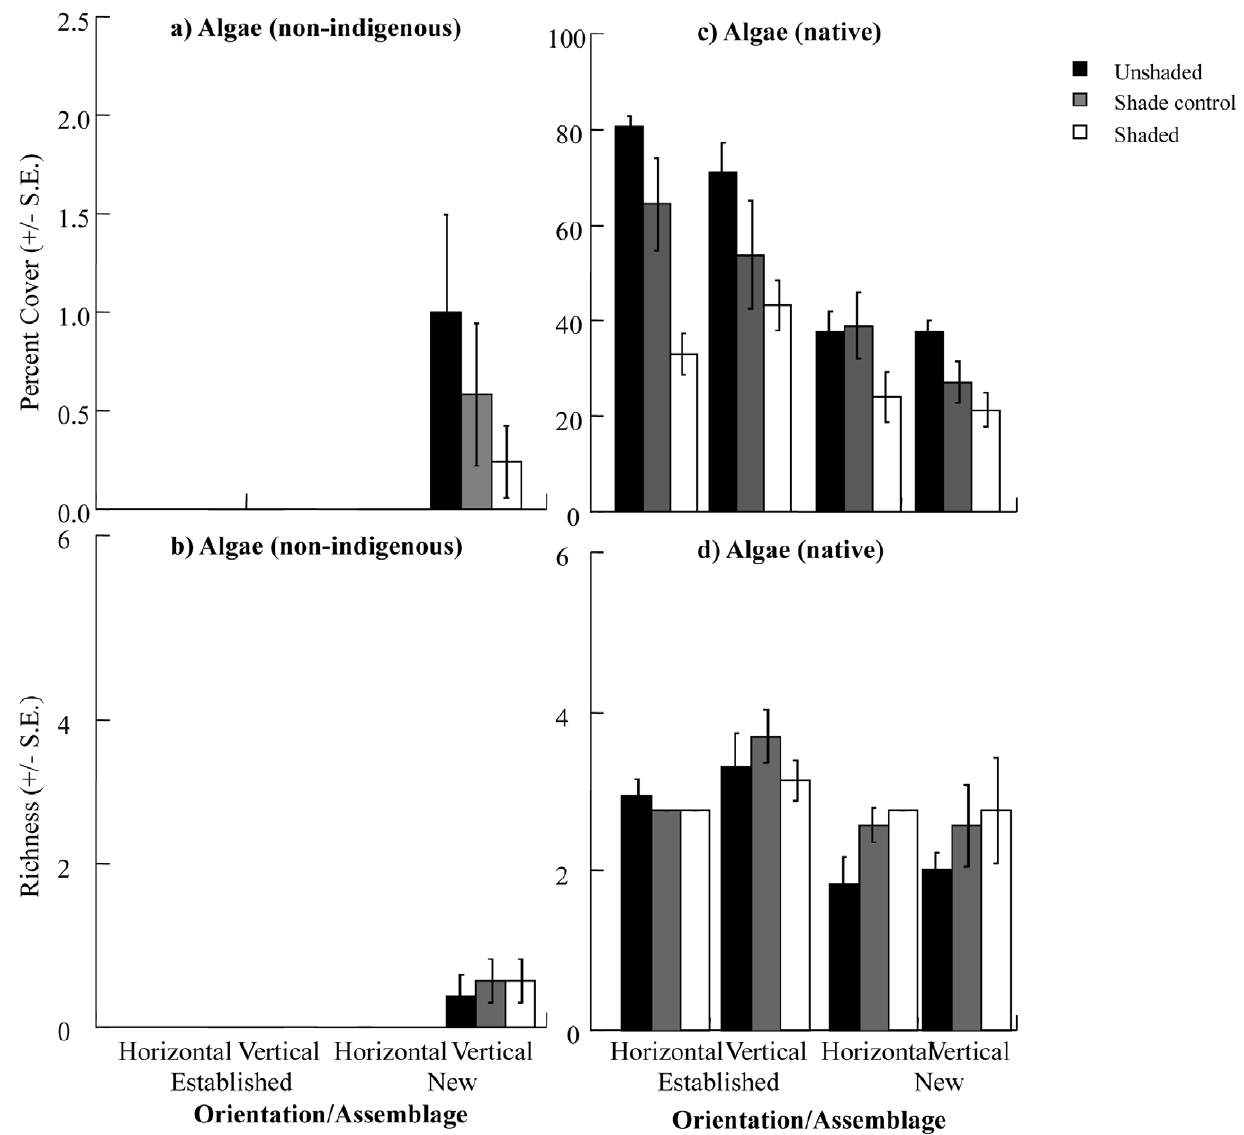
Figure 7. Percent covers and richness of algae sampled on experimental ‘‘reef’’. (a, b) non-indigenous algae and (c, d) native algae were sampled on experimentally deployed sandstone plates. Bars are separated by orientation (horizontal or vertical) and assemblage (new or established) and coded for shading treatment (unshaded, shade control or shaded).